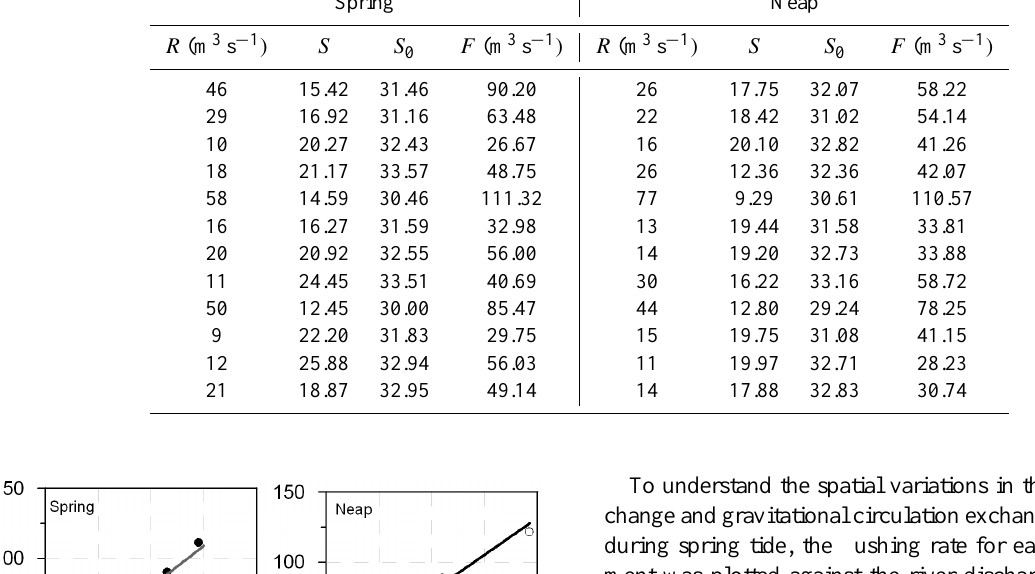
Table 2. Volume average salinity ( S ) for the Sumjin River Estuary, ocean salinity ( S 0 ), and river discharges ( R ) for various periods of the year along with calculated flushing rate ( F ) during spring and neap tides. Spring